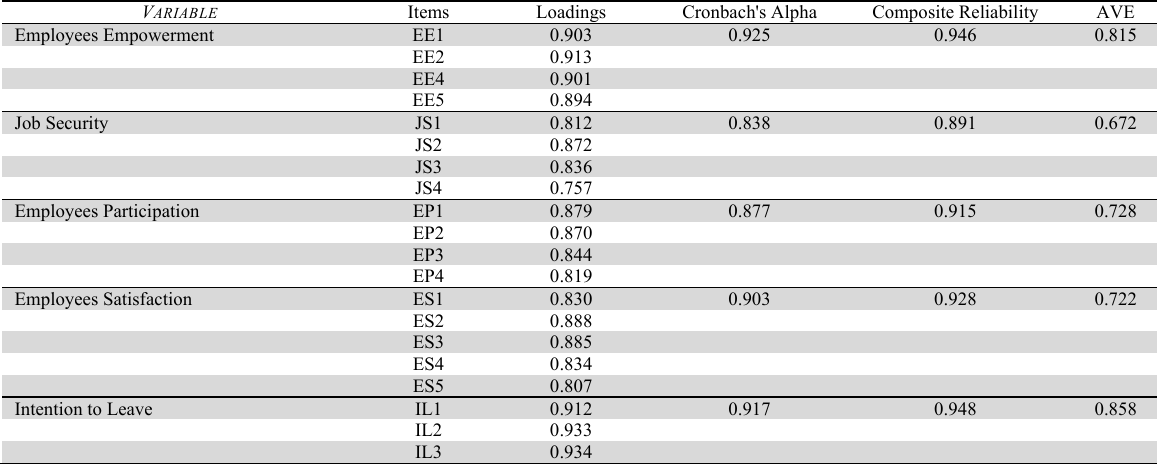
Convergent Validity